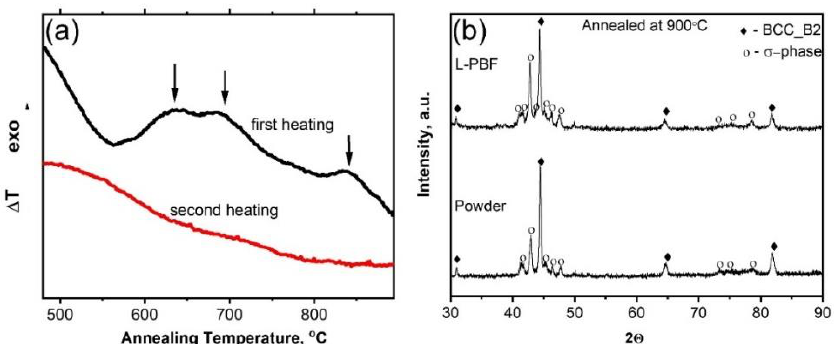
Figure 4. DTA curves of the powder ( a ) and XRD patterns of the powder and L-PBF sample after annealing at 900 °C for 1 h ( b ).